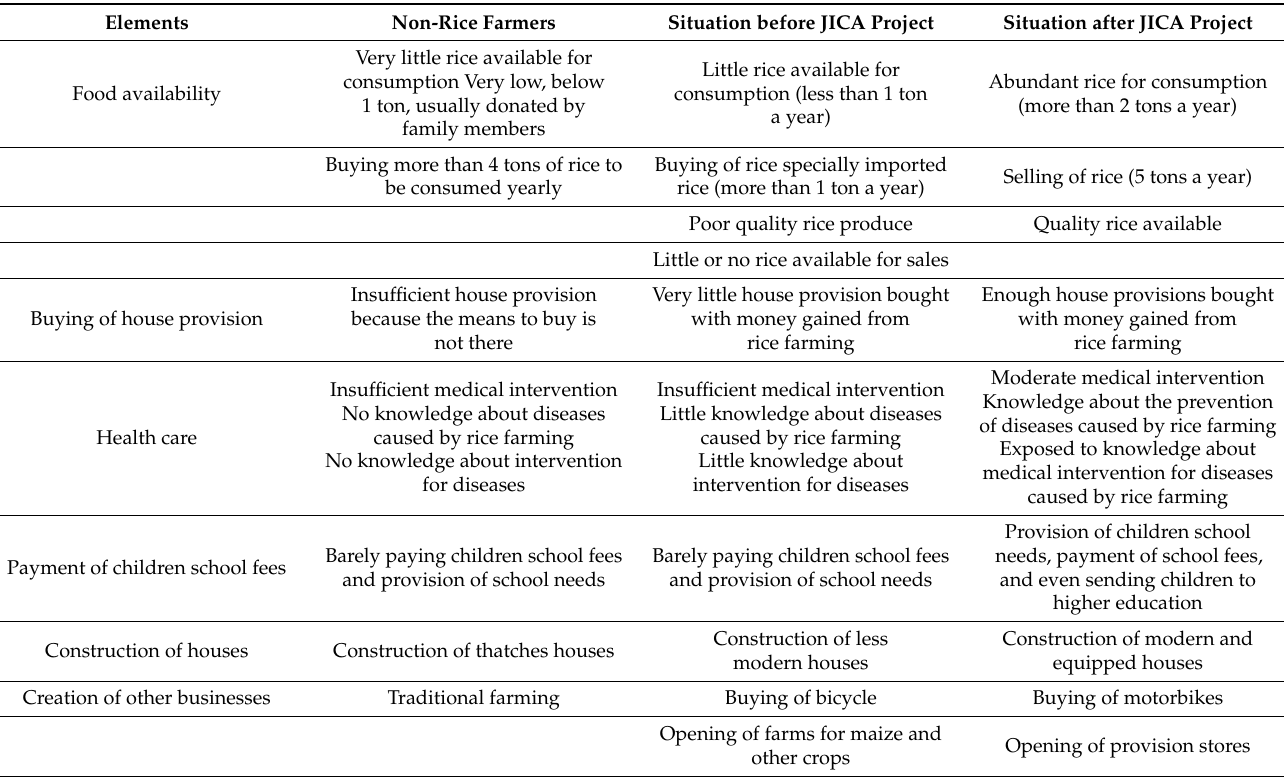
Table 5. Narrative comparison between beneficiaries and